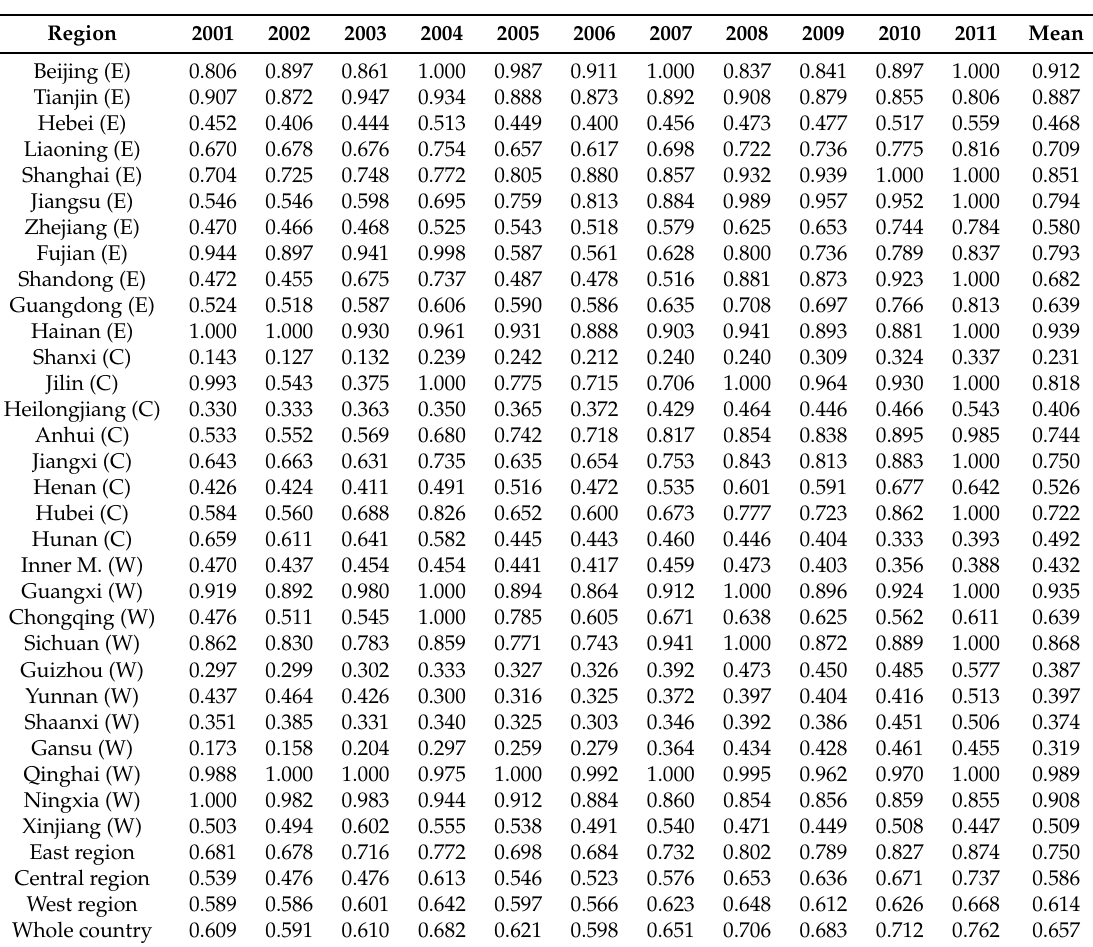
Table 3. Total-factor energy efficiency for each province from 2001 to